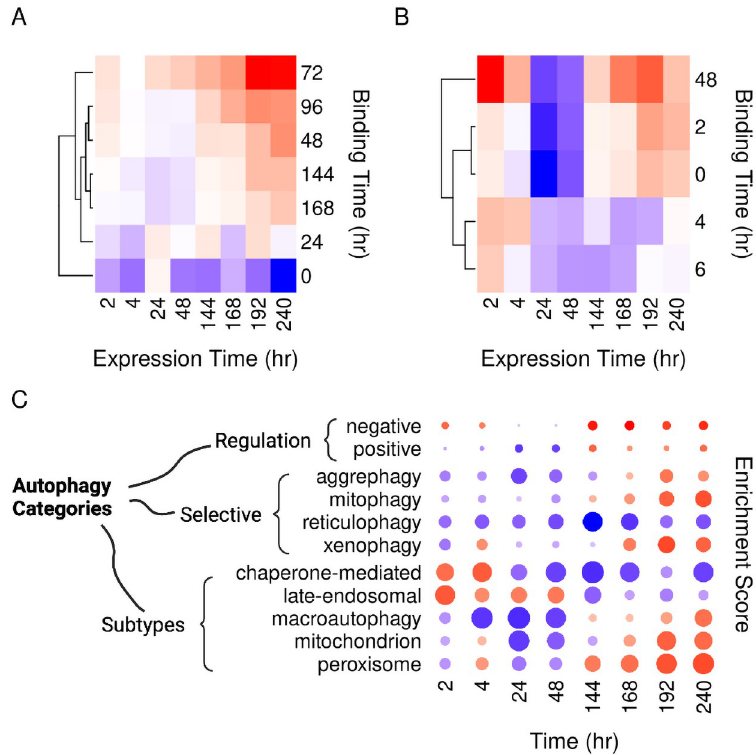
Fig 2. Expression of adipogenic transcription factor targets and enrichment of autophagy terms during the course of differentiation. Gene expression profiles of differentiating adipocytes were curated from previously published data as described in Fig 1. We curated another dataset of publicly available ChIP-seq samples in MDI-induced 3T3-L1 at different time points (Table 2). Read counts from the RNA-seq were used to estimate gene expression. Binding peaks from the ChIP-seq were used to identify the transcription factors binding sites and targets. Differential expression analysis was applied to quantify the change of autophagy gene expressions (fold-change) at different time points compared to pre-adipocytes. The median fold-change of A) PPARG or B) CEBPB targets at the corresponding time points (blue, low & red, high). C) Genes were ranked descendingly rank based on the fold-change. Enrichment of the autophagy “regulation,” “selective,” and “subtypes” terms was calculated by quantifying the over-representation of their members in the top or bottom ranks of the list (blue, negative & red, positive enrichment).